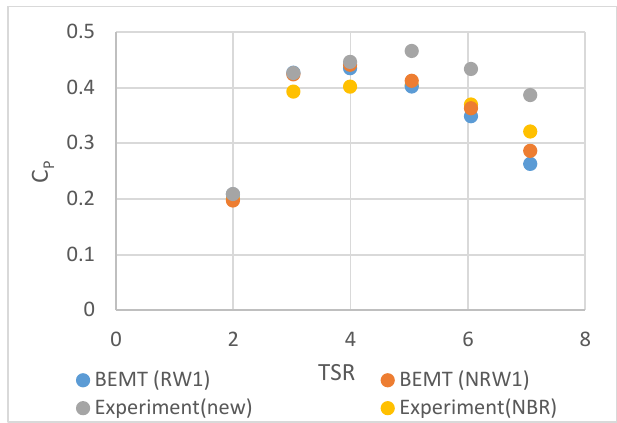
Figure 19. C P comparison between modified BEMT calculations and modified experimental data under wave-current interactions with a wave height of approximately 0.19m and an apparent wave period of 0.7s.